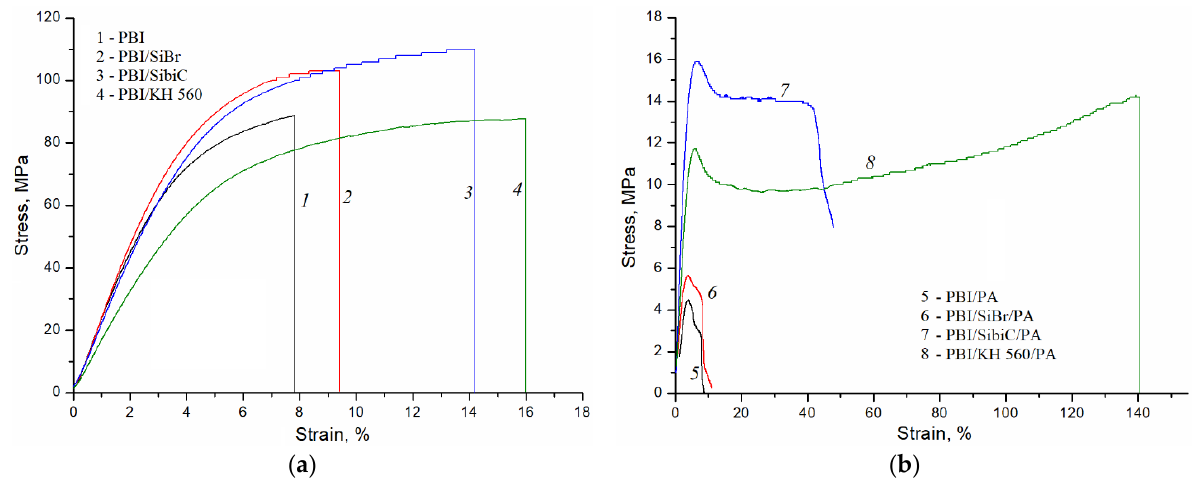
Figure 6. Stress – strain curves of undoped ( a ) and acid-doped ( b ) PBI (1, 5), PBI/SiBr-0.1 (2, 6), PBI/SibiC-0.1 (3, 7) and PBI/KH 560 (4, 8).